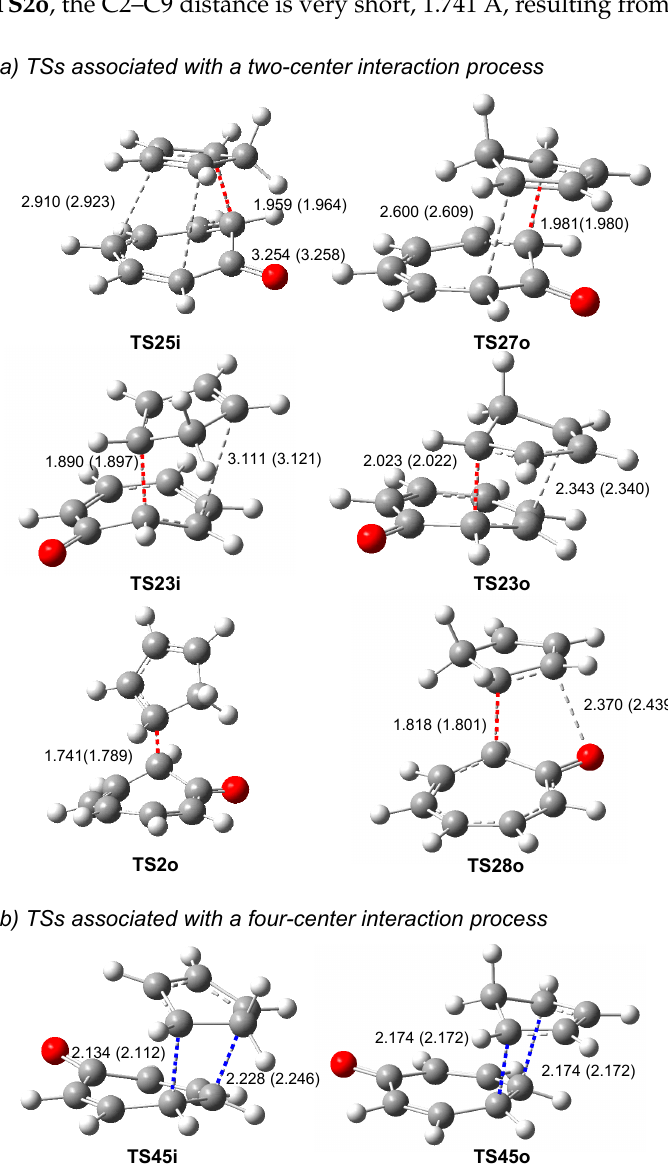
by the nucleophilic attack of the C9 carbon of Cp 3 on the C2 carbon of tropone 1 . At these asynchronous TSs, the distances between the interacting carbons are found in the range from 2.023 ( TS23o ) to 1.828 ( TS28o ) Å, while the lengths between the non-interacting carbons range from 2.343 ( TS23o ) to 2.910 ( TS25i ) Å. Note that at the most unfavorable TS2o , the C2–C9 distance is very short, 1.741 Å, resulting from its very advanced character.